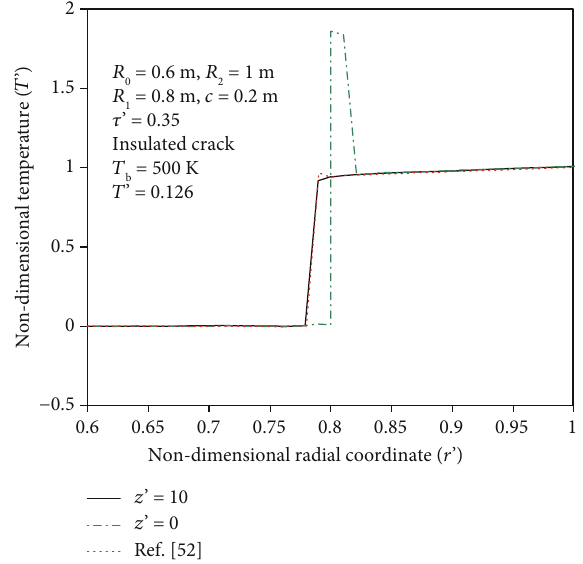
Figure 2: Validation of temperature distribution with Ref.